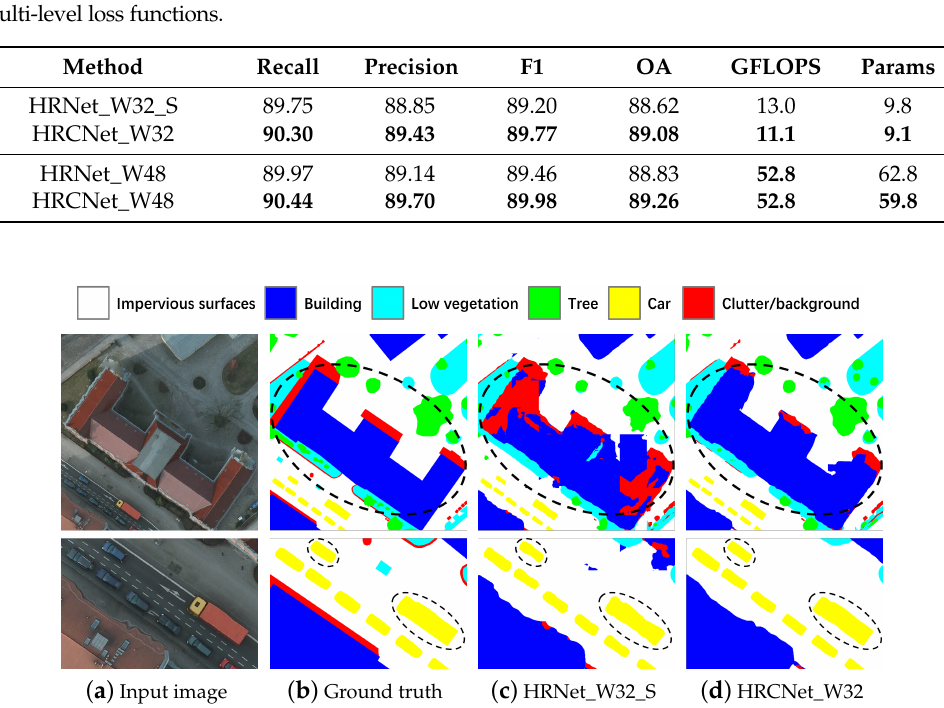
Figure 12. Our proposed modules significantly improve the segmentation of large objects, and for small objects, the boundary segmentation is